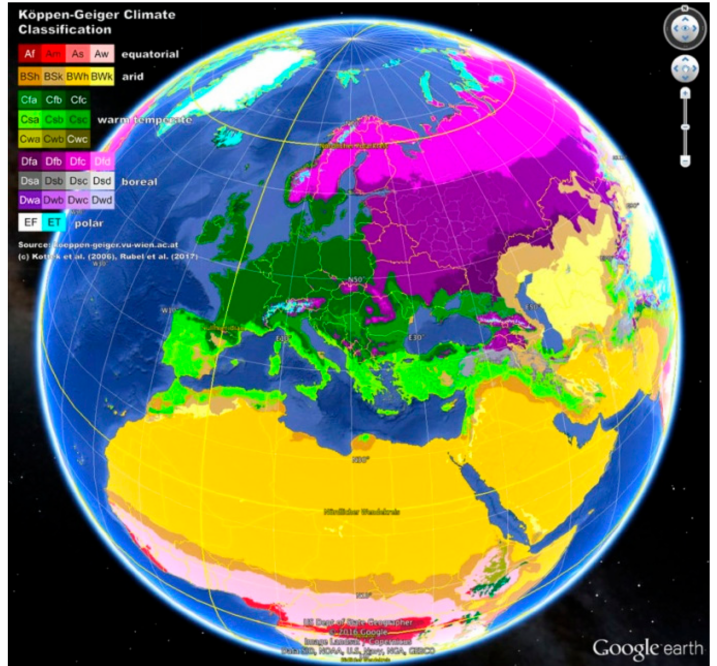
Figure 3. European map of Köppen–Geiger classification developed by the Climate Change and Infectious Diseases Group